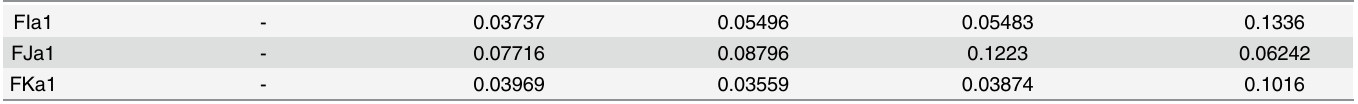
S1 Table. Data Underlying Primary Figures as Derived from Polychromatic Flow Cytome- try Analysis of Peripheral Blood